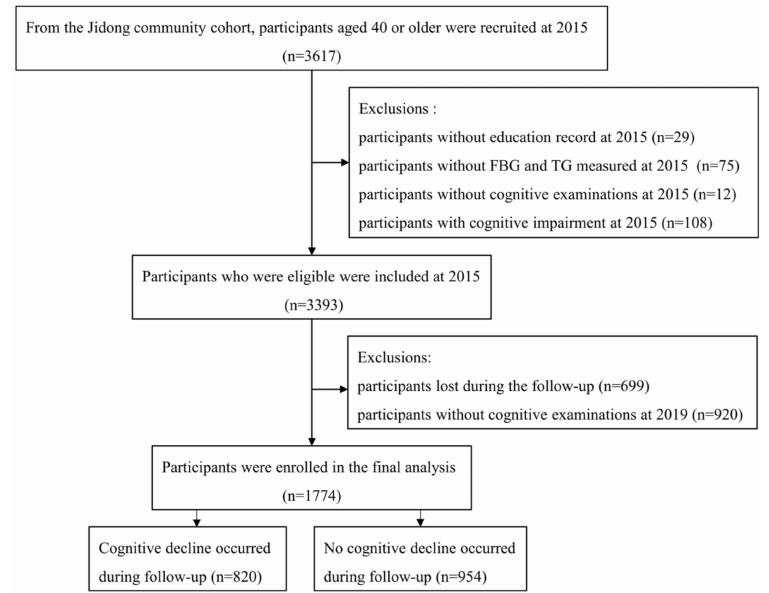
Figure 1. Flowchart of this study. Abbreviations: FBG, fasting blood glucose; TG, triglycerides.